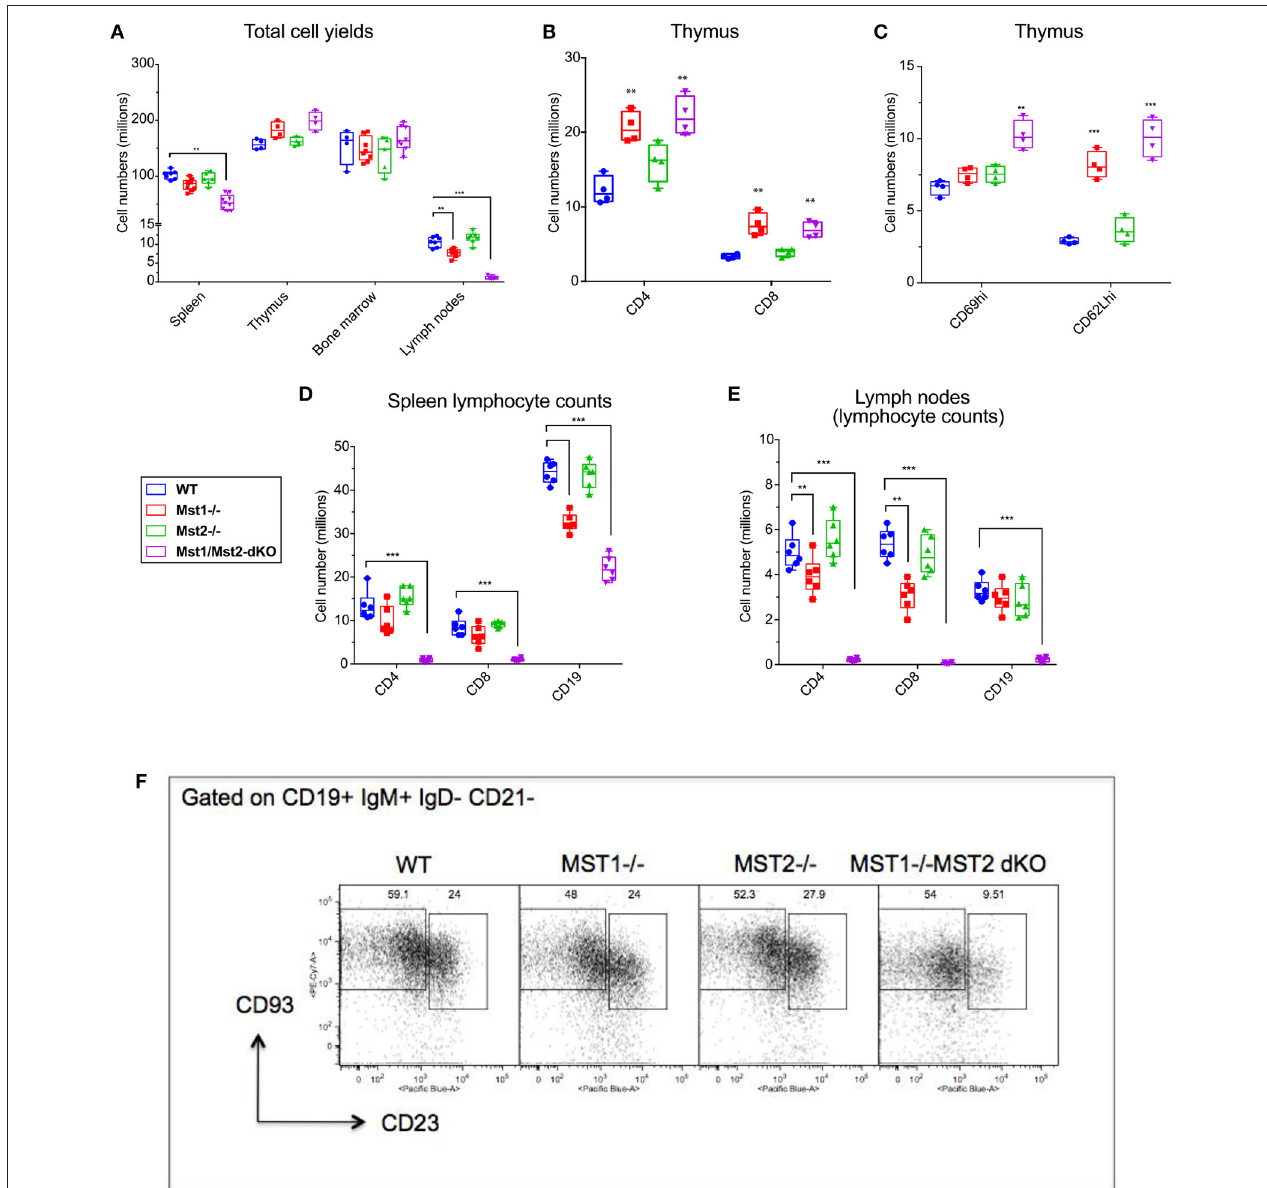
FIGURE 1 | Lymphocyte counts from primary and secondary lymphoid organs of Mst1 − / − and Mst1/Mst2-dKO mice: (A) Total cell yields from Spleen, LN, bone marrow, and Thymus harvested from Mst1 − / − , Mst2 − / − , Mst1/Mst2-Dko, and WT controls at 8 weeks of age. ( n = 6–7, error bars depict mean ± SD). (B) Total CD4-SP and CD8-SP T cell counts from thymus harvested from Mst1 − / − , Mst2 − / − , Mst1/Mst2-dKO and WT controls at 8 weeks of age. ( n = 4, error bars depict mean ± SD). (C) Total immature and mature CD4-SP T cell counts from thymus harvested from Mst1 − / − , Mst2 − / − , Mst1/Mst2-dKO, and WT controls at 8 weeks of age. ( n = 4, error bars depict mean ± SD). (D) Total CD4 + and CD8 + T cell and CD19 + B cell counts from spleens harvested from Mst1 − / − , Mst2 − / − , Mst1/Mst2-dKO, and WT controls at 8 weeks of age. ( n = 5–6, error bars depict mean ± SD). (E) Total CD4 + and CD8 + T cell and CD19 + B cell counts from pooled popliteal, inguinal, and axillary lymph nodes harvested from Mst1 − / − , Mst2 − / − , Mst1/Mst2-dKO, and WT controls at 8 weeks of age. ( n = 5–6, error bars depict mean ± SD). (F) Flow cytometry analysis of T1 and T2 transitional B cells in the spleen. ** p < 0.01, *** p <